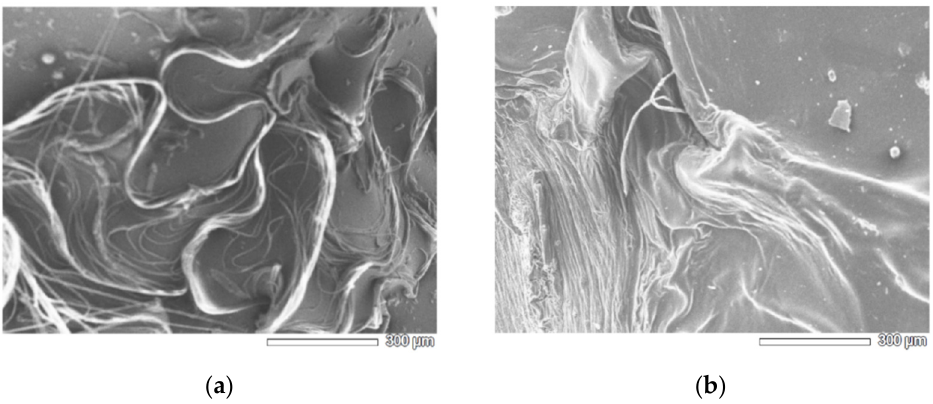
Figure 4. SEM images on a representative macro area (100× g mag.) of ( a ) CHg and ( b ) CHg-TA.